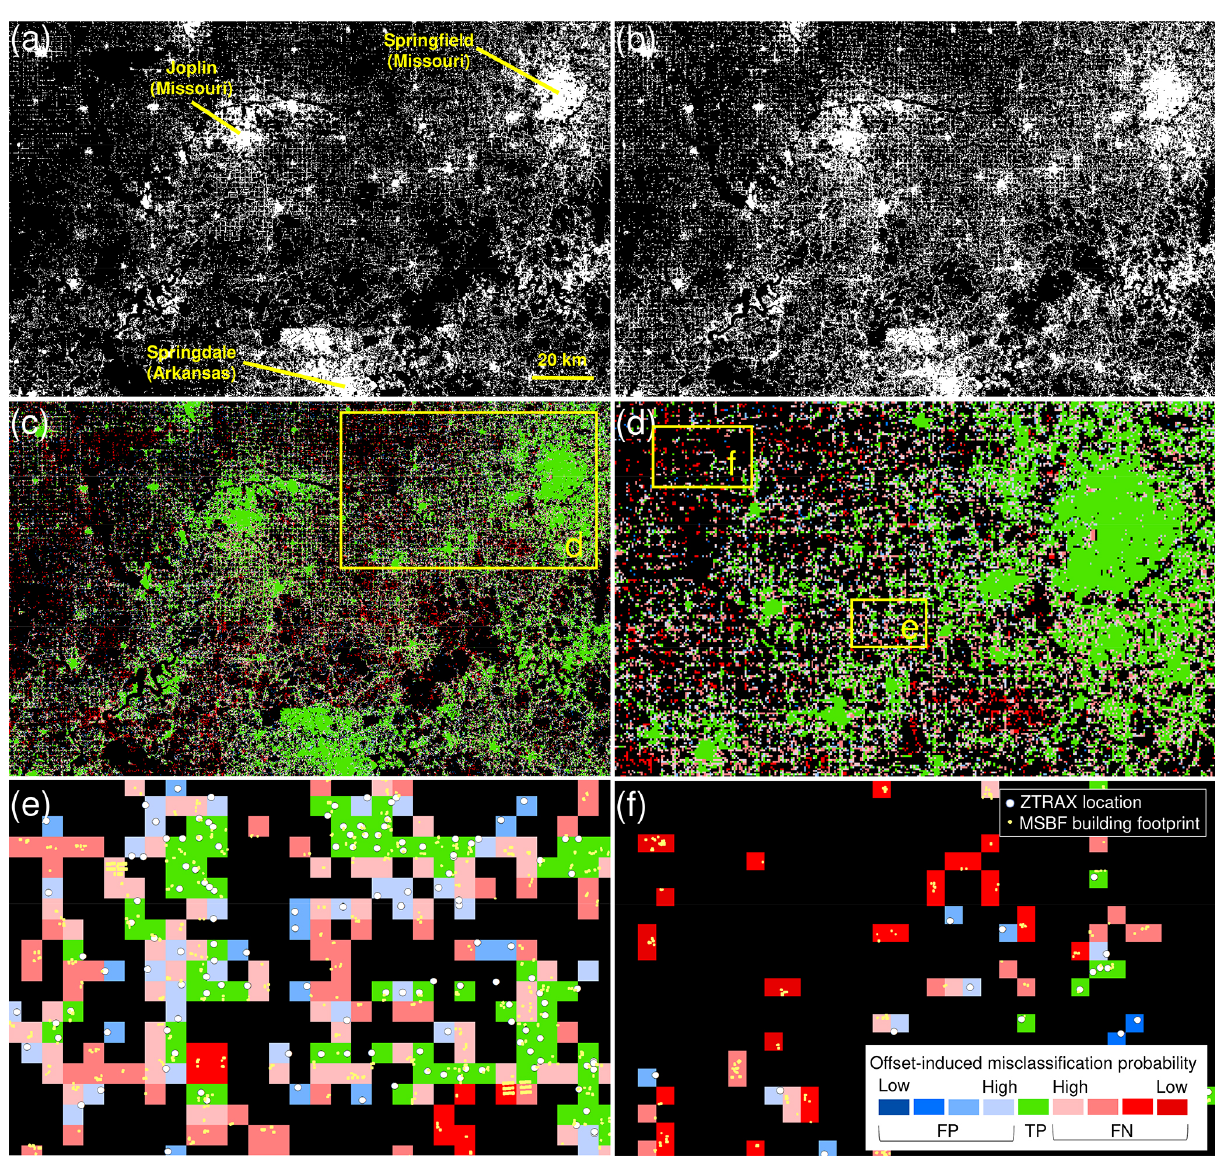
Figure 9. Cross-scale positional uncertainty surfaces: (a) contemporary, ZTRAX-derived, settled areas (i.e. BUA surface from 2016); (b) cor- responding reference surface derived from MSBF data; (c) resulting spatial disagreement surface indicating the estimated offset-induced misclassification probability; (d) subset shown for a region west of Springfield, Missouri; and enlargements showing regions characterized by (e) disagreement likely introduced by spatial offsets and (f) false negatives unlikely to have been introduced by spatial offsets but rather by missing